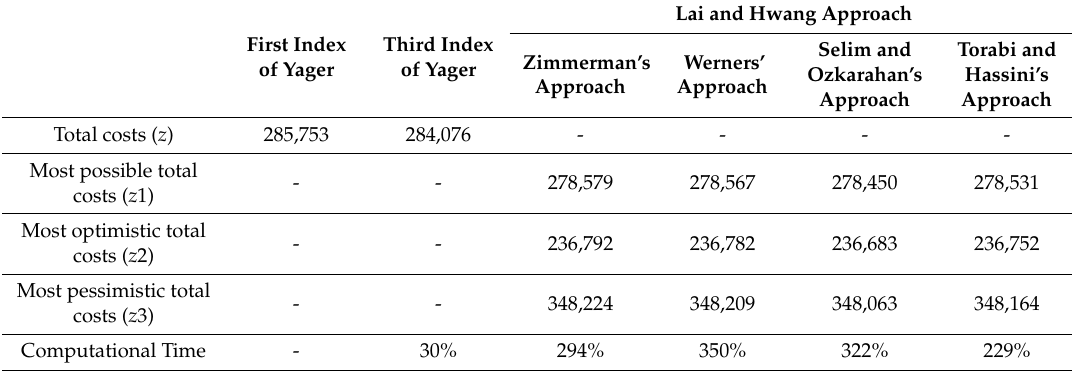
Table 6. Optimization results of the model statistics ( €